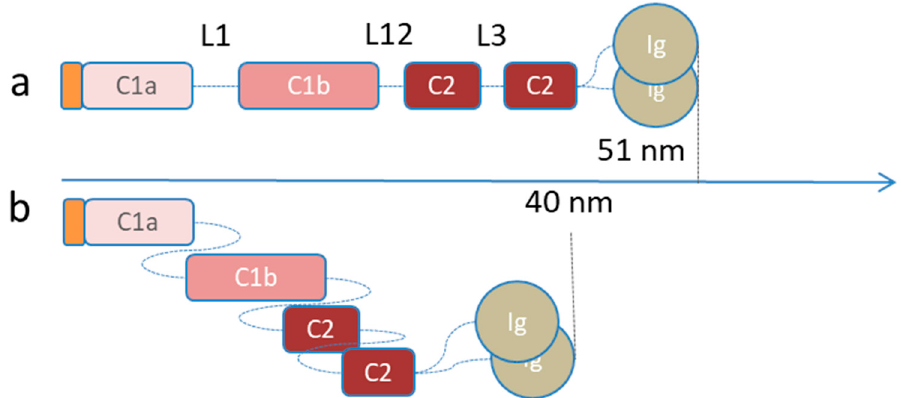
Figure 7. Stable conformations of the lamin dimers. ( a ) Lamin dimers in semi-relaxed configuration (total length about 50 nm). ( b ) The rod of lamin dimers can compress via three sequential tandem staggering of linkers L1, L12, and L3 (total length about 40 nm) for electrostatic interactions.